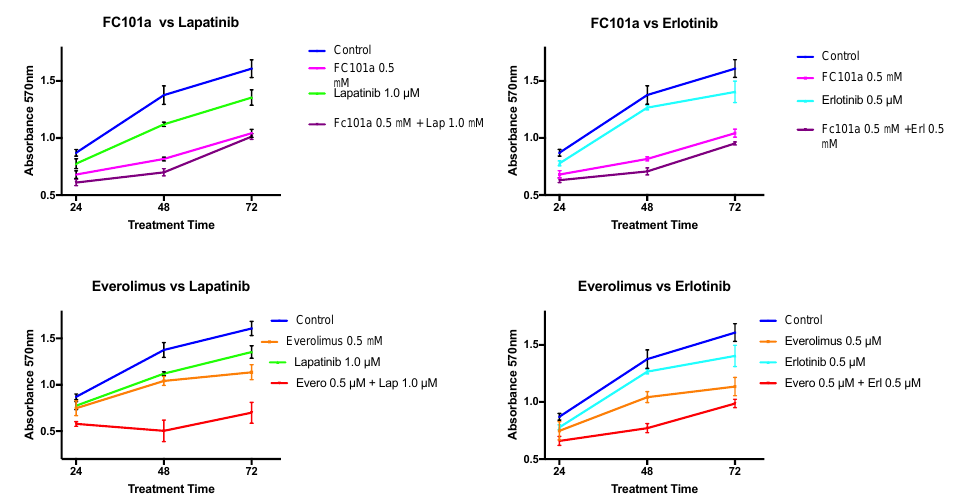
Figure 5. MTT viability assay time response curve. Treatment concentrations included FC101 (0.5 µ M), lapatinib (1.0 µ M), erlotinib (0.5 µ M), everolimus (0.5 µ M), and combinations of either FC101 (0.5 µ M) or everolimus (0.5 µ M) with lapatinib (1 µ M) or erlotinib (0.5 µ M). The graph represents normalized color intensity A 570 (% control) vs. time course treatments at 24, 48, and 72 h.